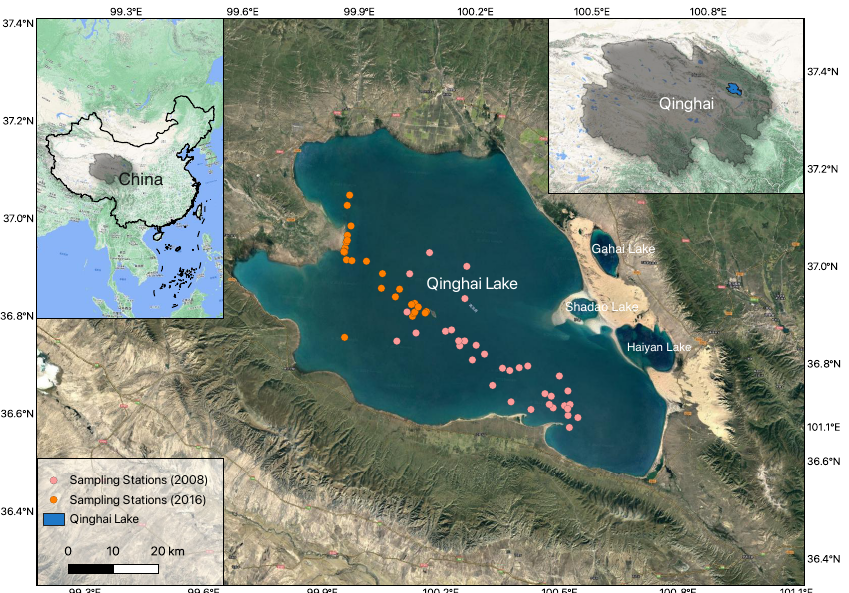
Figure 1. Location of Qinghai Lake (The pink and orange points are the sampling stations in the field surveys of 2008 and 2016, respectively. The miniature maps in the upper right and left corners indicate the locations of Qinghai Lake in Qinghai Province and Qinghai in China,